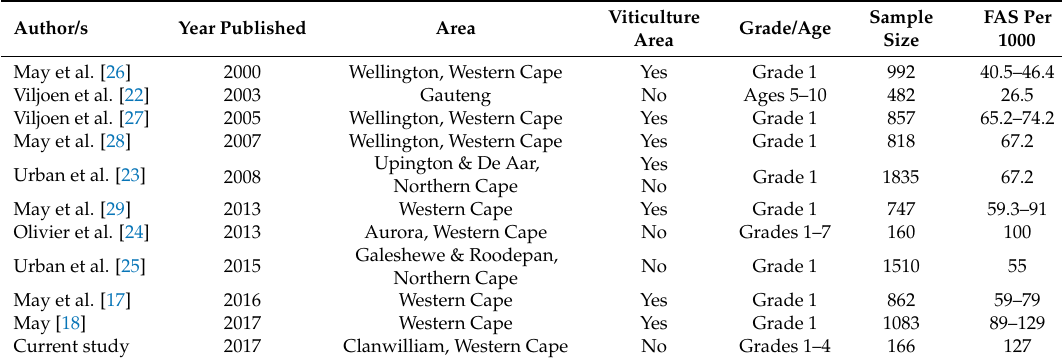
Table 3. FAS prevalence rates from studies in South